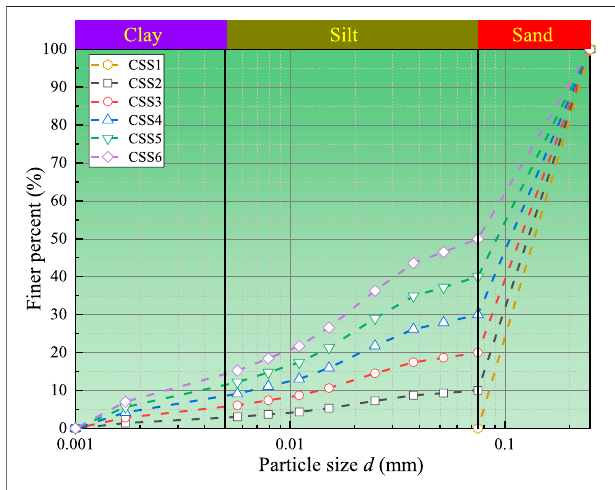
FIGURE 2 | Particle size distribution curves of calcareous silty sand.